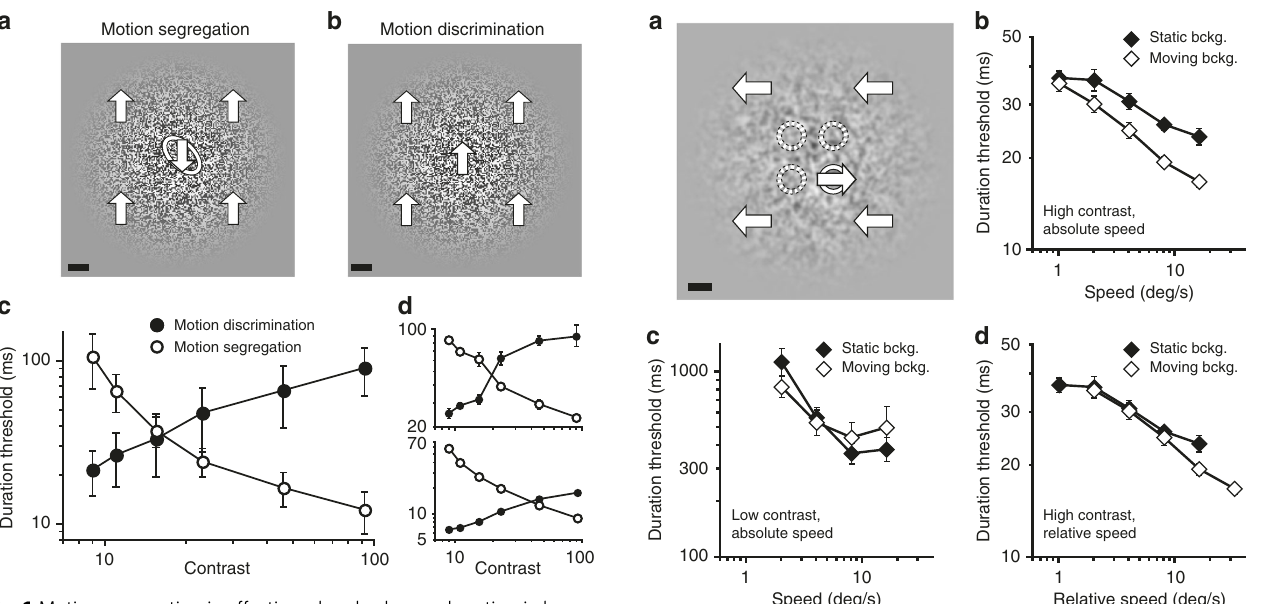
Fig. 1 Motion segregation is effective when background motion is less discriminable. a In the motion segregation task, observers identi fi ed the tilt of an oval motion-de fi ned object presented on a moving background. The object could be either tilted left (as shown) or tilted right. Block arrows and the object outline are shown for illustration purposes only. Scale bar is 1°. b In the motion discrimination task, the background motion from panel A was presented in isolation, and observers were simply asked to identify its motion direction (which could be either upward or downward). Scale bar is 1°. c Group data showing the opposite effects of stimulus contrast on motion discriminations and motion segregation. d Data for two individual observers. All error bars are